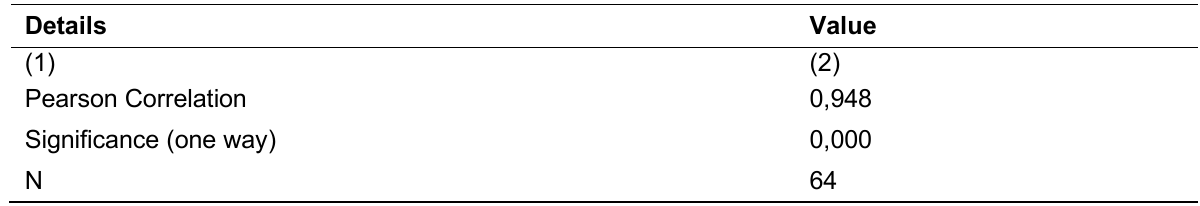
Table 1: Pearson Correlation of agriculture and processing industries East Java Year 1995-2010